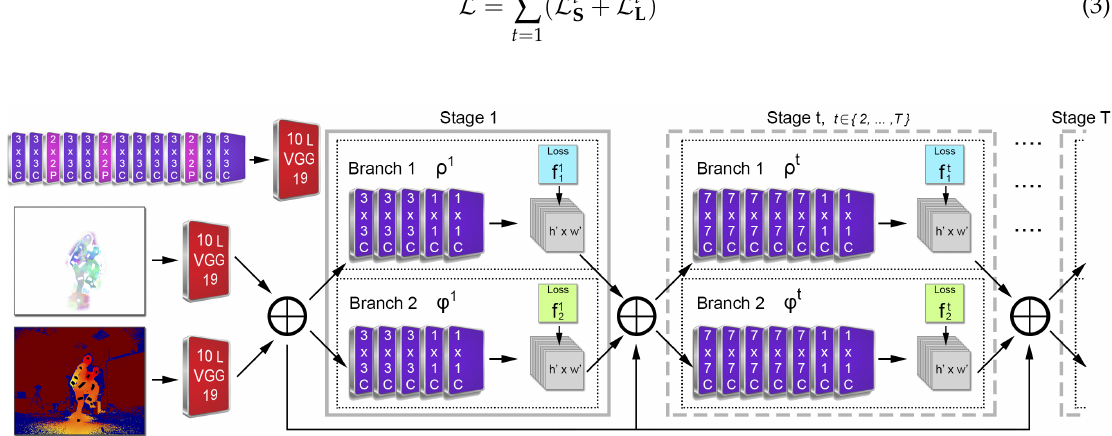
Figure 6. DeepMoCap two-stream, multi-stage FCN architecture. The outcome of each stage t ∈ { 2, . . . , T } and the feature set F are fused and given as input to the next